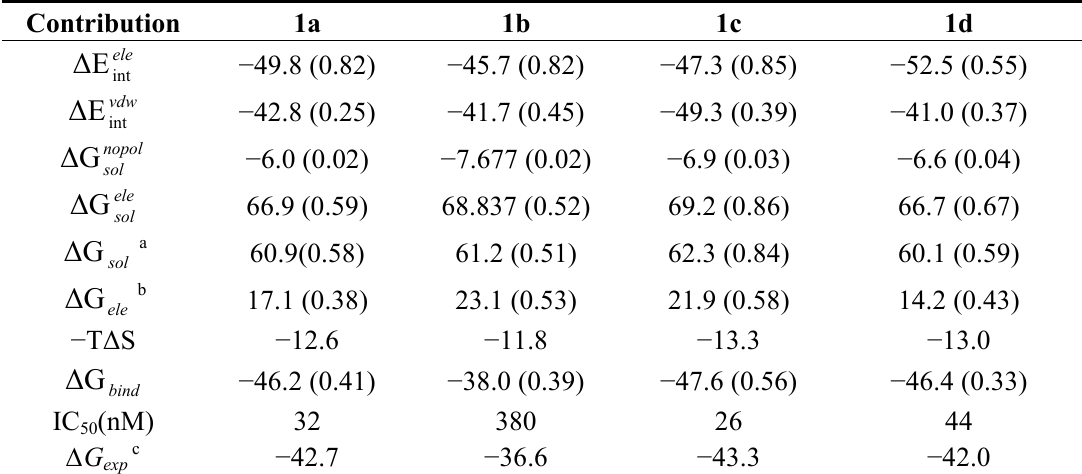
Table 1. Binding free energies and individual energy terms of inhibitors in complex with TPH1